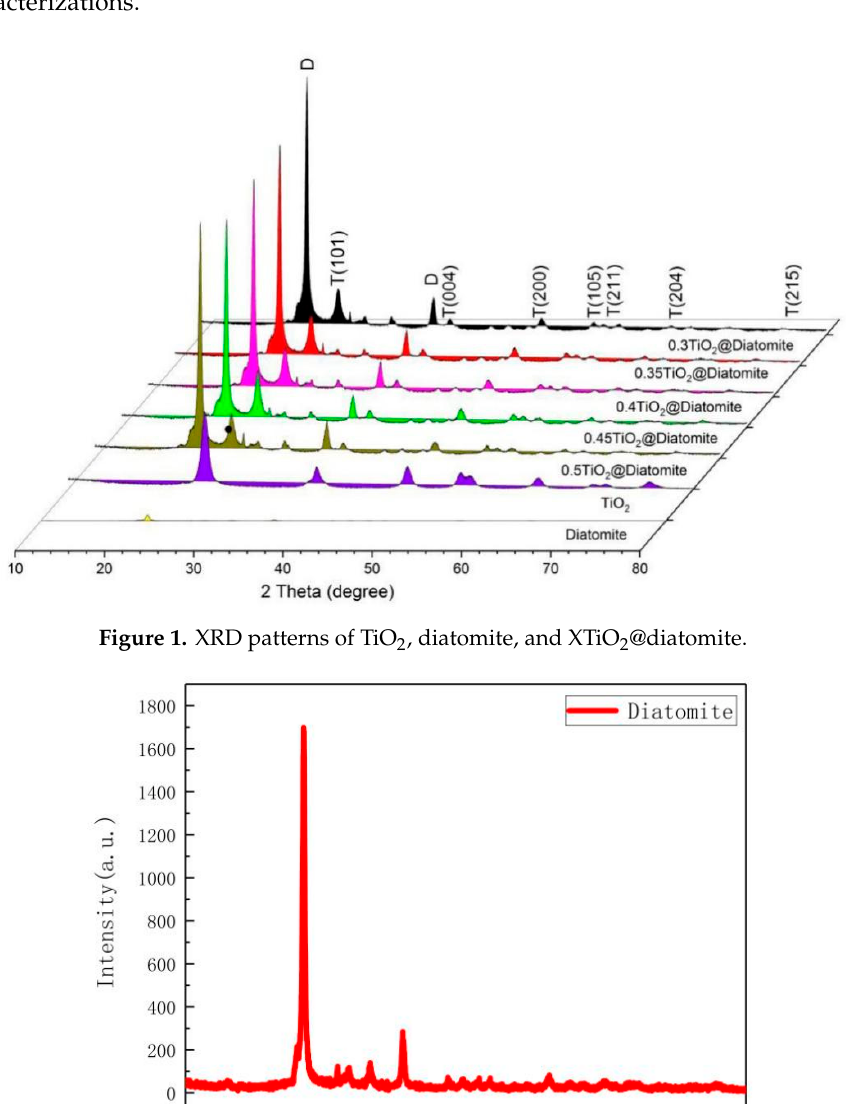
Table 1. Chemical analyses of diatomite [32].